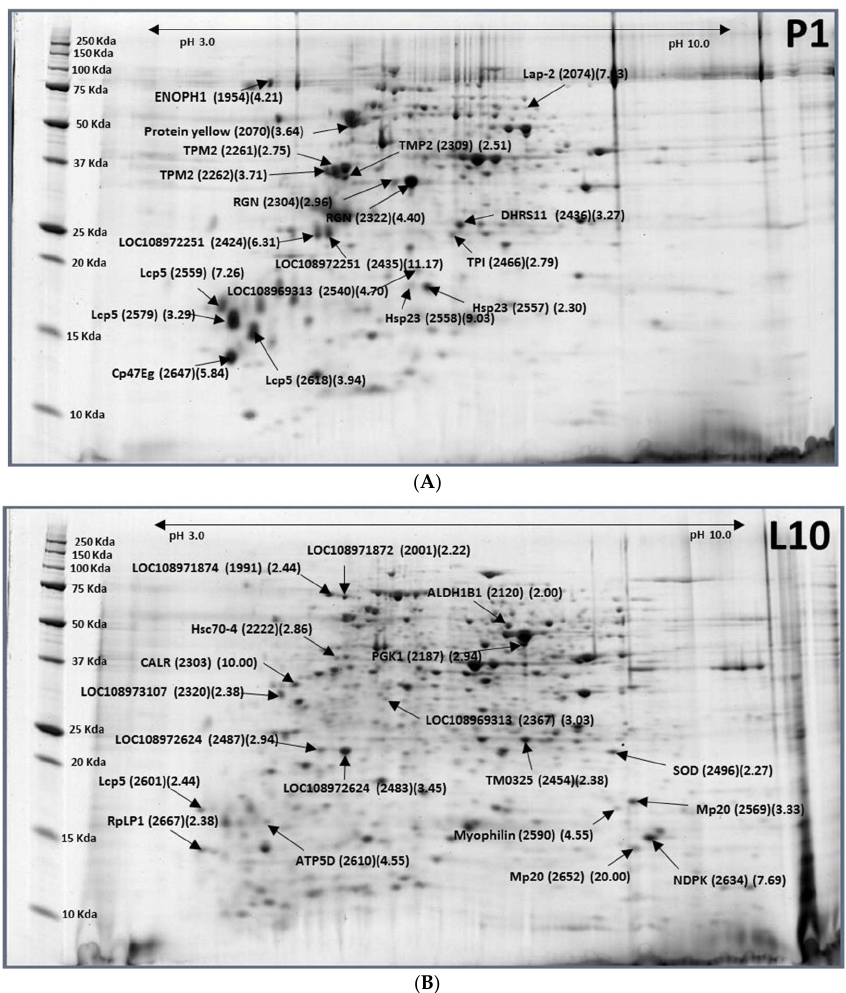
Figure 2. Representative images of 1-day-old pupae (P1) ( A ) and 10-day-old larvae (L10) ( B ) of Bactrocera latifrons . Images were labelled with protein names (spot ID#) (P1/L10 ratios). Table 2. Differentially expressed proteins between 10-day-old larvae and 1-day-old pupae of Bactrocera latifrons . Accession